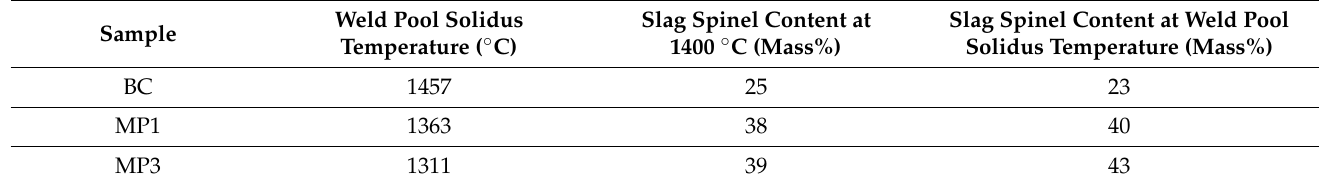
Table 7. Comparison of weld pool solidus temperatures and slag spinel content.